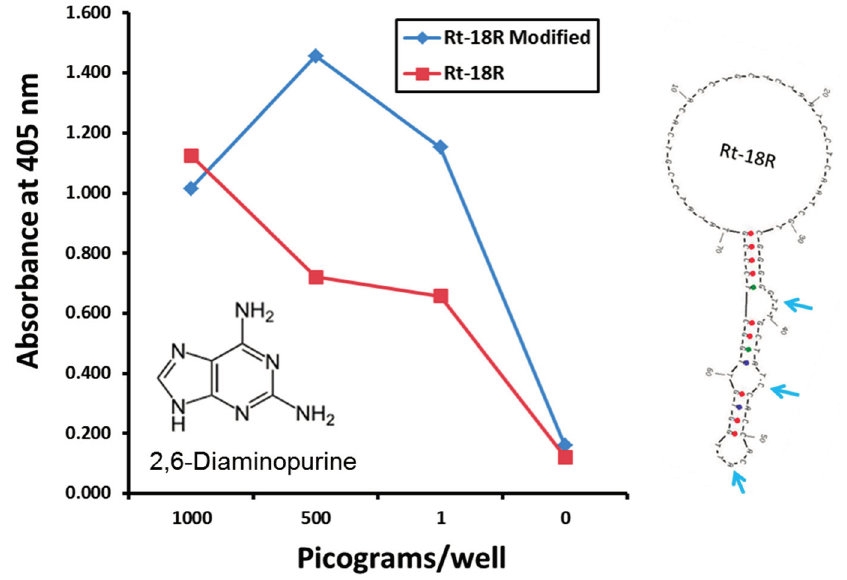
Figure 2. Improved Rickettsia aptamer performance in an ELISA-like assay with diaminopurine (DAP) built into three putative R. typhi aptamer binding pockets.